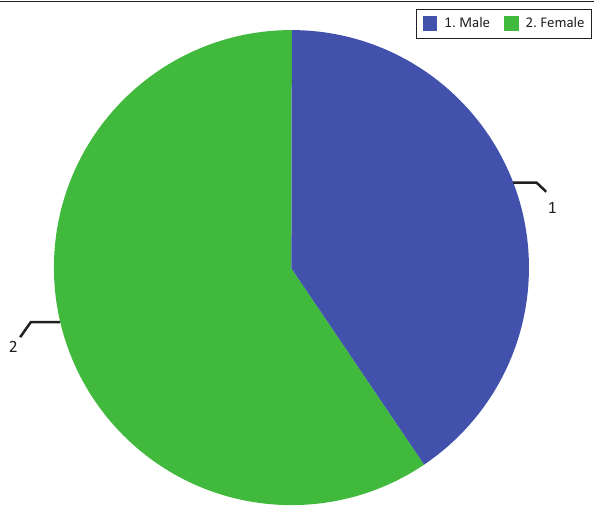
FIGURE 2: Distribution of respondents’ responses on sex (female respondents 38 [59.4 % ] as compared with male respondents 26 [40.6 % ]).